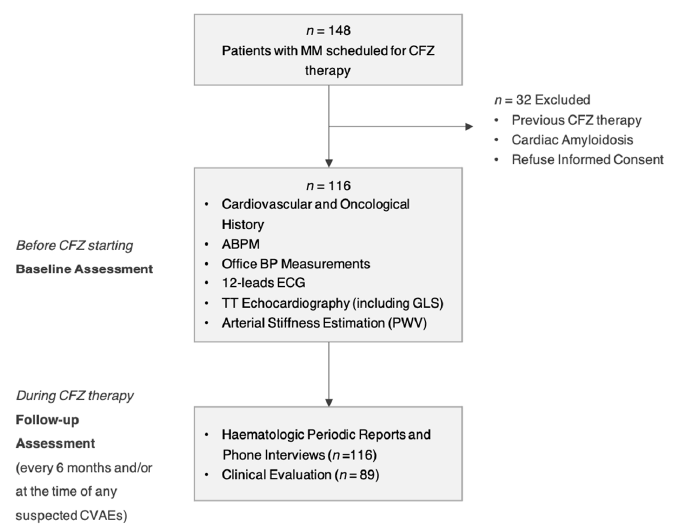
Figure 1. Flow-chart of the Study Protocol .